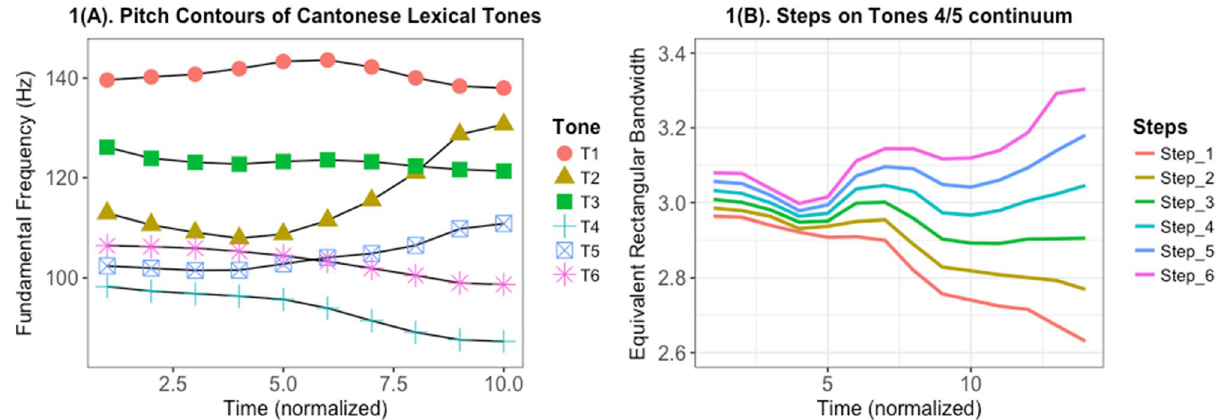
Figure 1. ( A ) Pitch contours of lexical tones in Cantonese. F0 ranges: T1: 135–146 Hz, T2: 105–134 Hz, T3: 120–124 Hz, T4: 85–99 Hz, T5: 102–113 Hz, T6: 100–106 Hz; ( B ) Pitch contours of the six-step T4/T5 equidistant continuum. Step 1 = original T5; Step 6 = original